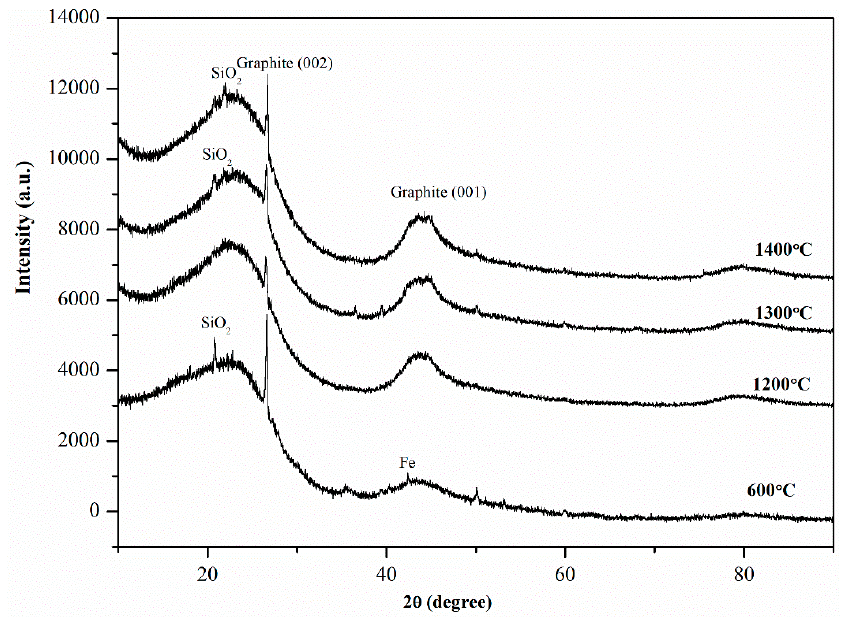
Figure 6. X-ray diffraction spectra of CNTs after microwave treatment at different